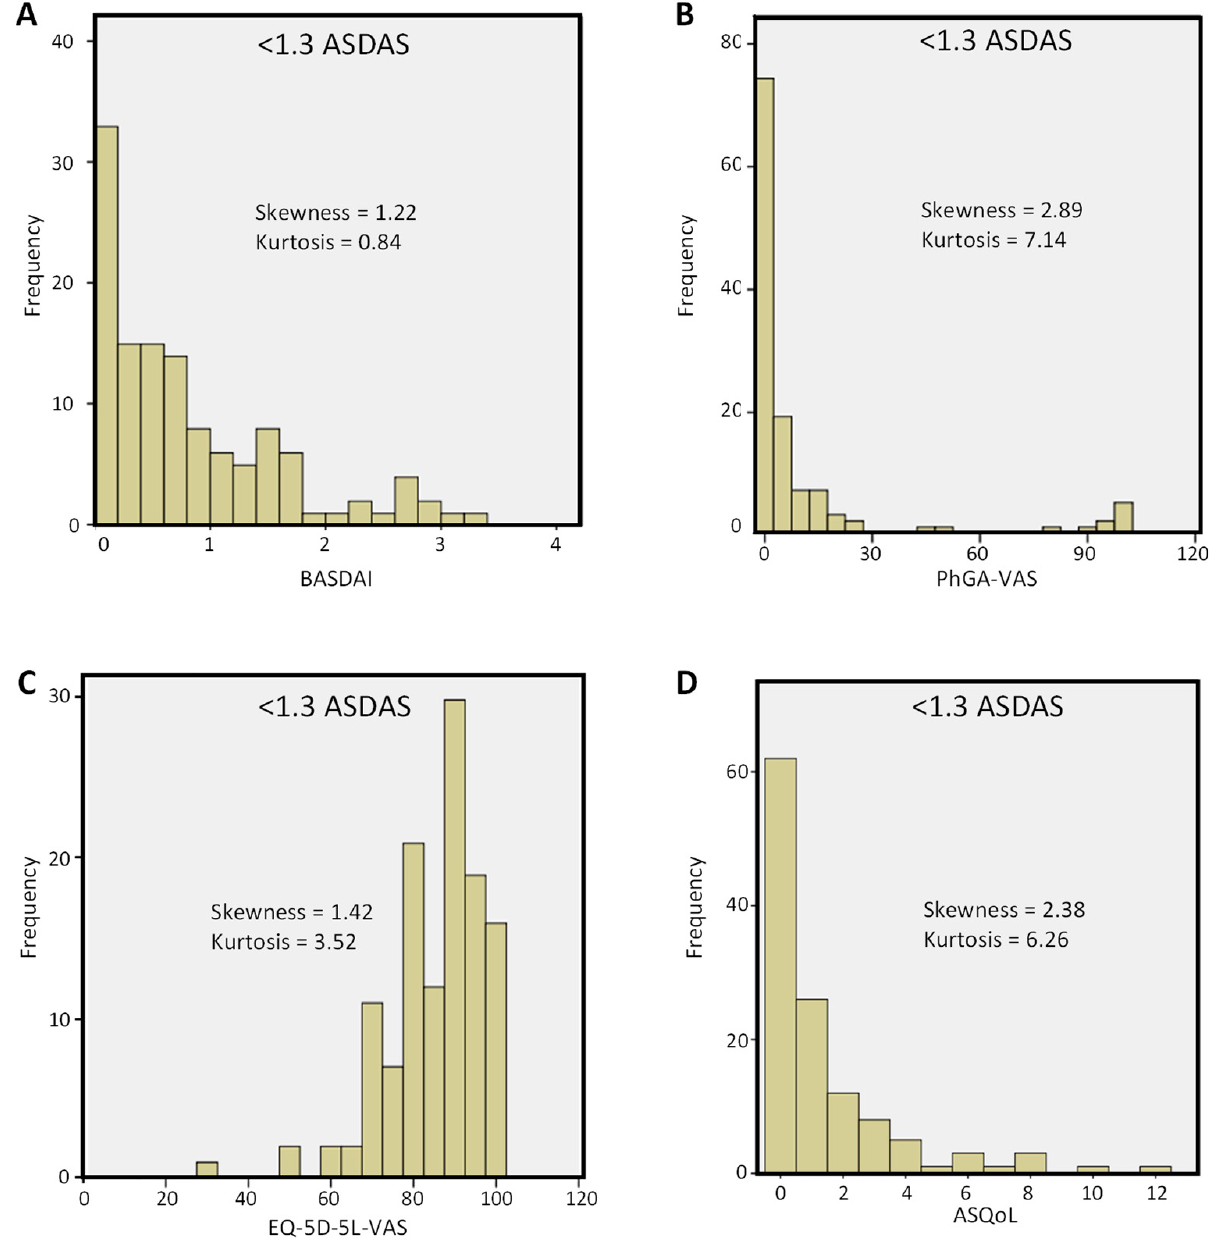
Figure 1. Frequency distribution of ( A ) BASDAI, ( B ) PhGA-VAS, ( C ) EQ-5D-5L-VAS, and ( D ) ASQoL scores in patients with axSpA in remission (ASDAS < 1.3). ASDAS = Ankylosing Spondylitis Disease Activity Score; ASQoL = Ankylosing Spondylitis Quality of Life; BASDAI = Bath Ankylosing Spondylitis Disease Activity Index; EQ-5D-5L-VAS = EuroQoL 5-Dimension 5-Level visual analogue scale component of EQ-5D-5L to describe the health status of the patient; PhGA-VAS = Physician Global Assessment-visual analogue scale.